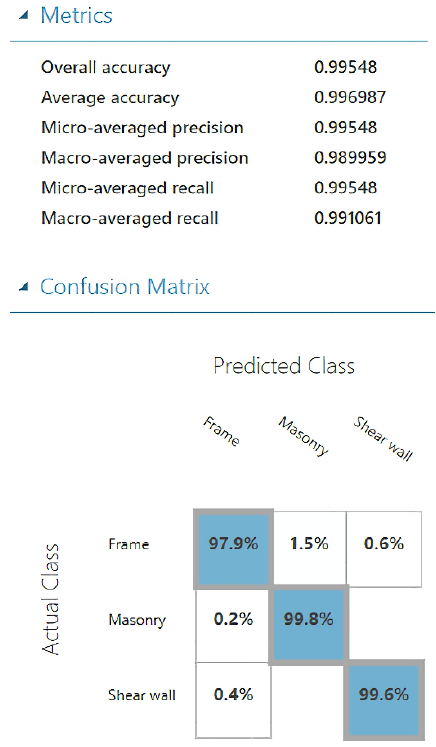
Figure 27. Prediction accuracies and confusion matrix for the case of Tongzhou downtown.